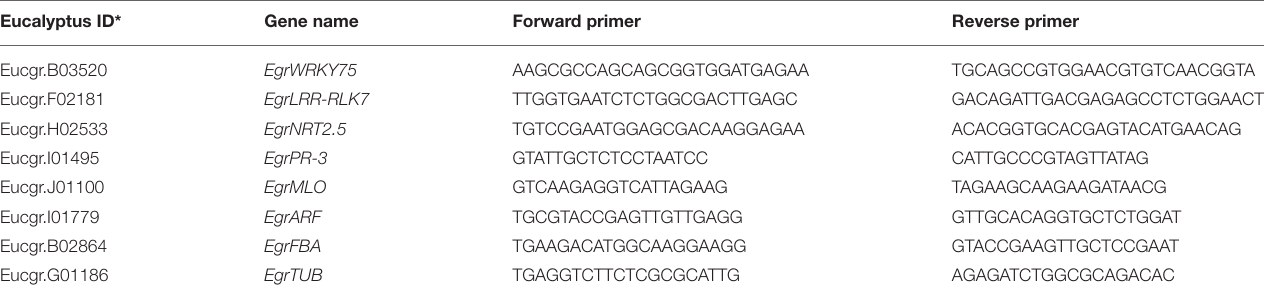
TABLE 1 | Primer sequences for Eucalyptus nitens RT-qPCR target and reference